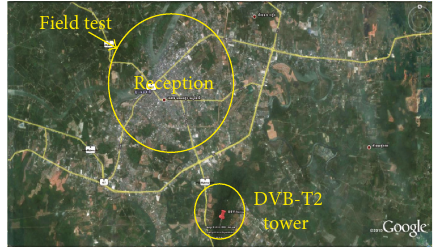
Figure 4: Measurement locations in Surathani